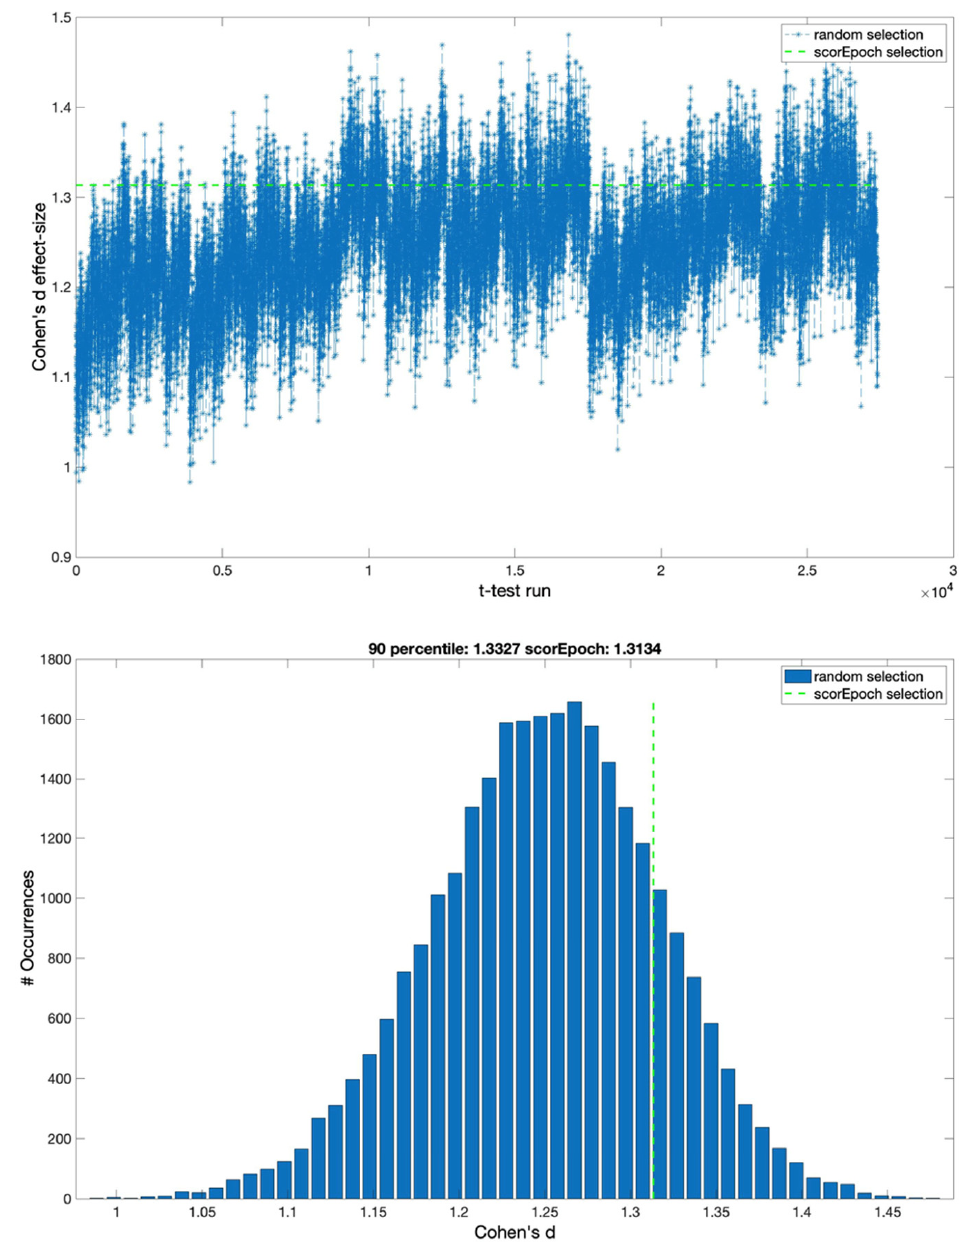
Figure 3. Cohen’s d effect sizes for random selection and Scorepoch selection using a time window equal to 2 s. ( upper panel ) The ‘time course’ of the effect size computed using a sequential random selection. The effect size values are reported in the y-axis, while the x-axis indicates the t-test with a sequential random selection. The green dashed line represents Cohen’s d value obtained by selecting the epochs using Scorepochs. ( lower panel ) Cohen’s d effect size distribution for the random epoch selection and the Scorepoch selection. The effect size values are reported on the x-axis, while the y-axis indicates the occurrences of specific effect size values. The vertical green dashed line represents Cohen’s d value from selecting the 4 epochs suggested by Scorepochs.